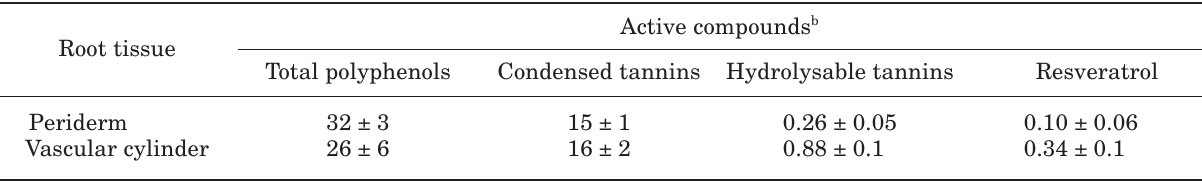
Table 3. Concentration of total polyphenols (gallic acid g/100 g f wt), condensed tannins (catechin equivalents g/100